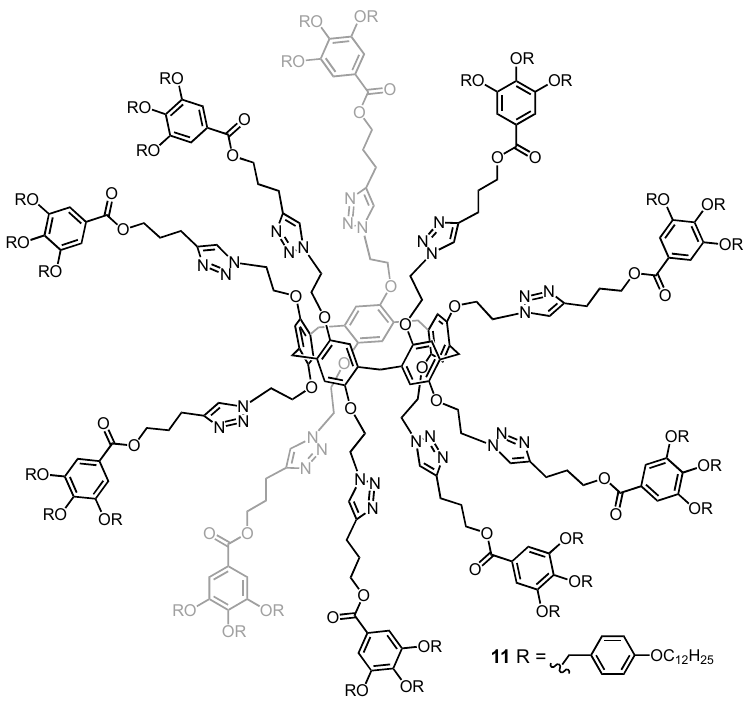
Figure 7. Dendronized pillar[5]arene 11 (MW: 11896.72).